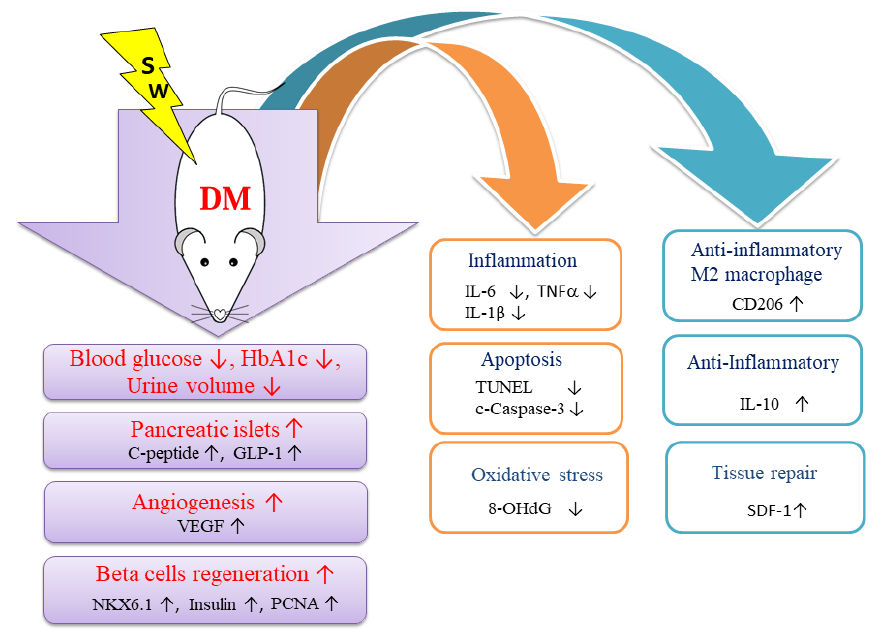
Figure 7. Proposed mechanisms underlying the therapeutic effects of low-energy SW on DM.